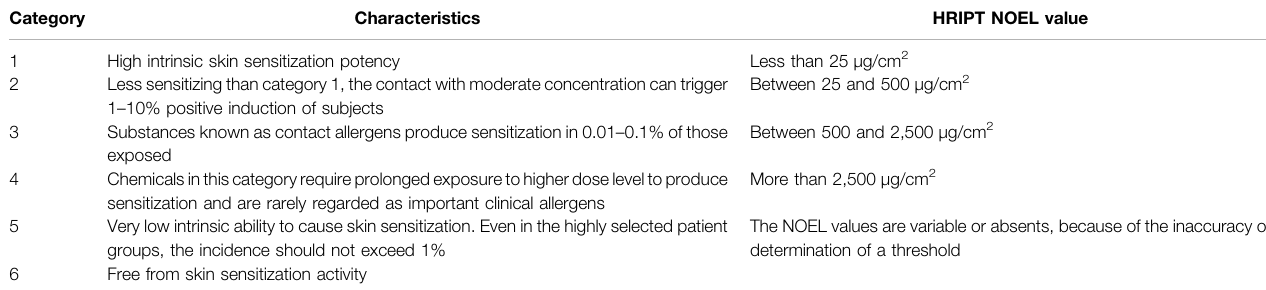
TABLE 2 | The skin sensitization categories based on the NOEL value of HRIPT. Category